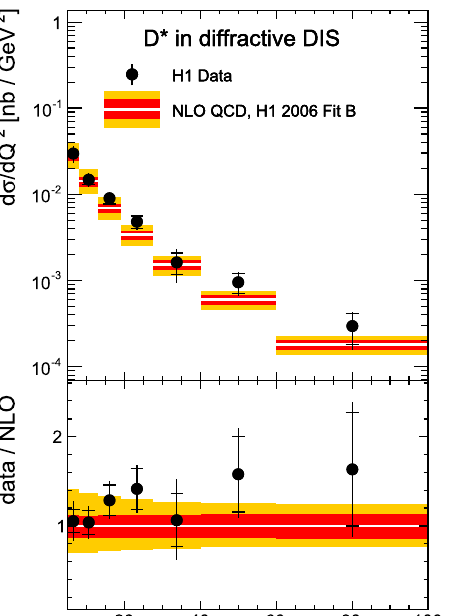
Fig. 4 Bin averaged single-differential D ∗ cross sections as a func- tion of Q 2 and y . Data are shown as dots , where the inner error bars indicate statistical uncertainties and the outer error bars represent the statistical and the full set of systematic uncertainties added in quadra- ture. The central NLO QCD prediction by HVQDIS is shown as a white